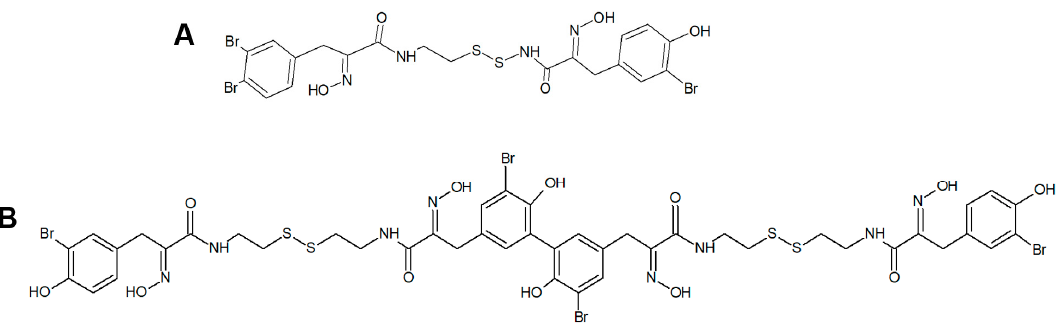
Figure 5. ( A ) Structures of psammaplin A ( A ) and bisaprasin ( B ).